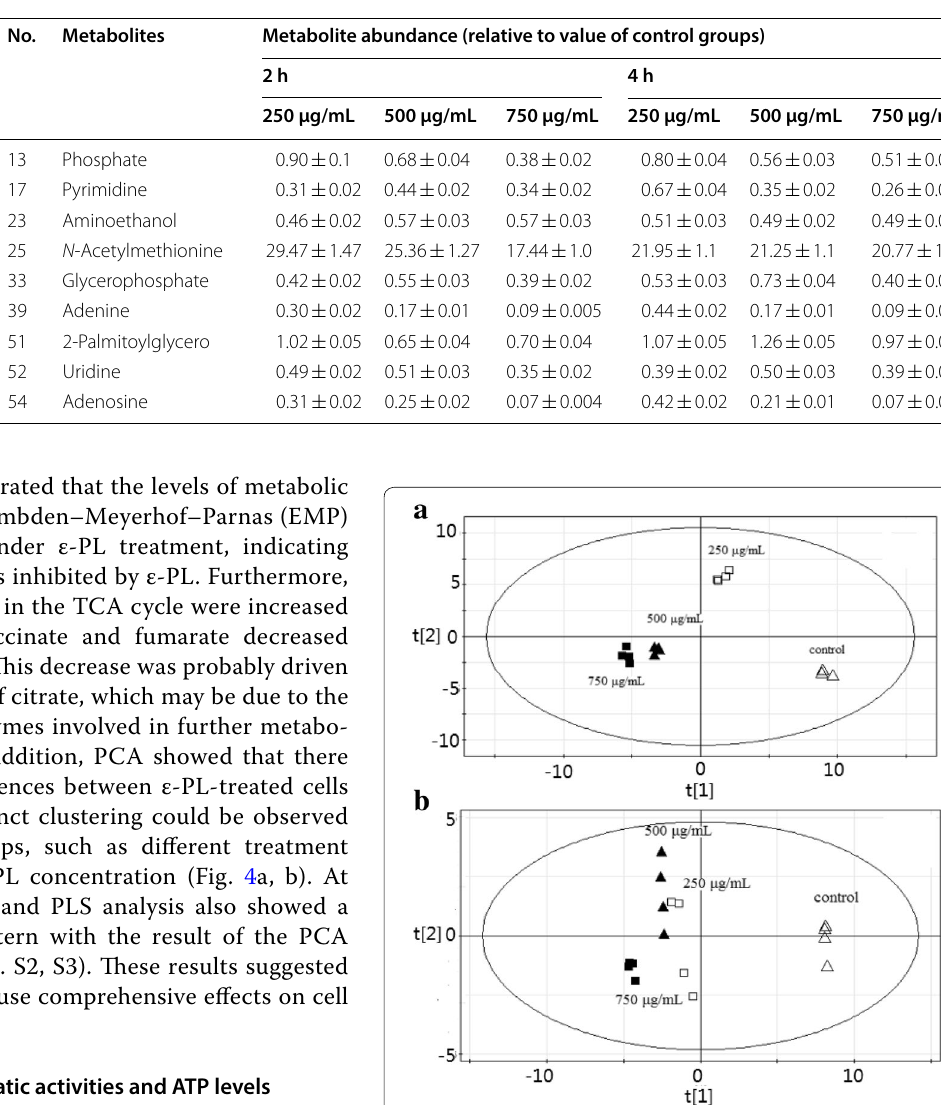
Fig. 4 PCA scores plot for control group and ε-PL-treated group. a Sampling time: 2 h; b sampling time: 4 h. In the scores plot, the confidence interval was defined by the Hotelling’s T2 ellipse (95% confidence interval), and observations outside the confidence